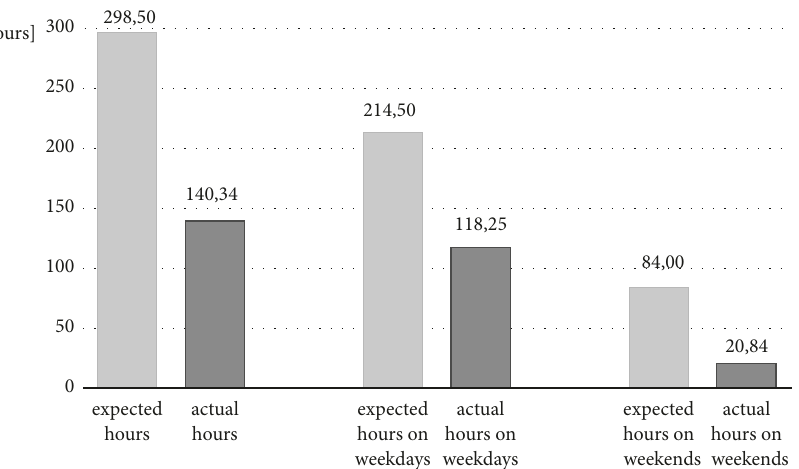
Figure 8: Descriptive analysis of expected and actual hours worn in relation to all days, weekdays, and the weekends for MSS.